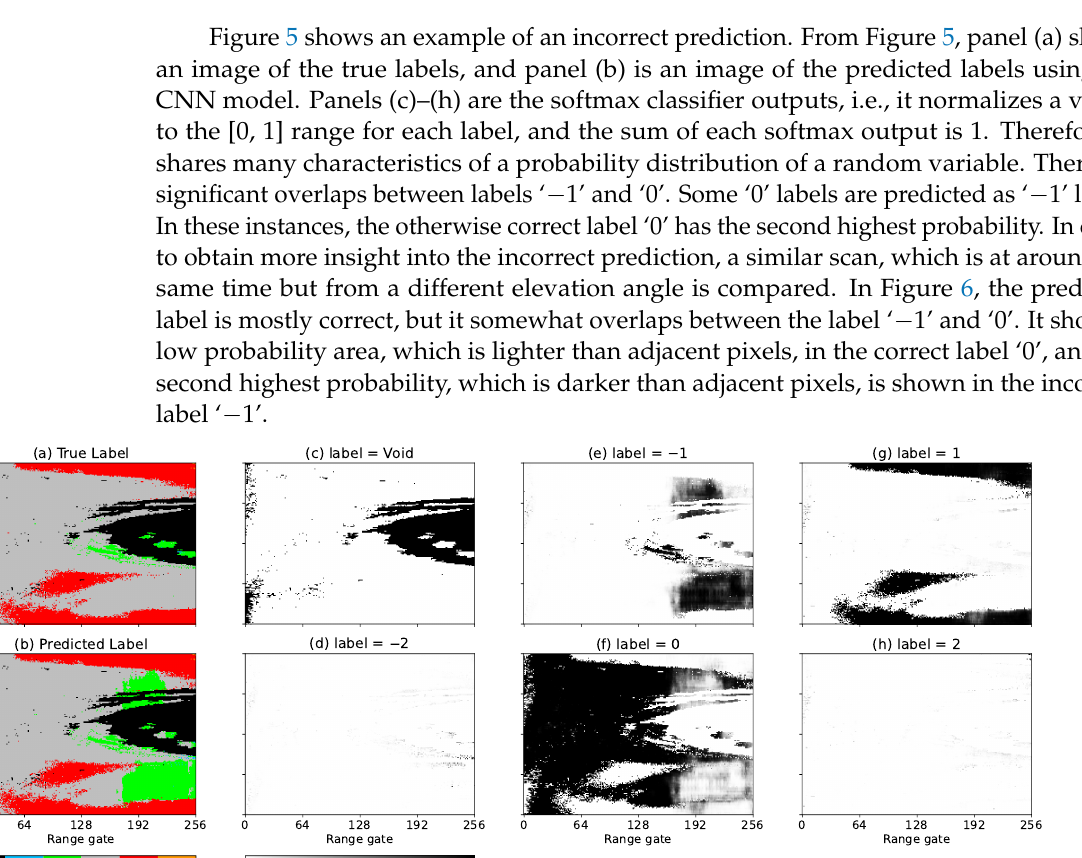
Figure 4. Comparison results on velocity dealiasing performance between the proposed CNN method (blue) and the conventional region-based unwrapping method (red). Comparison is performed with µ A ( top ) and σ A ( bottom ). The left panels show the performance from the mostly filled precipitation, and the right panels show the performance from the sparsely filled precipitation.